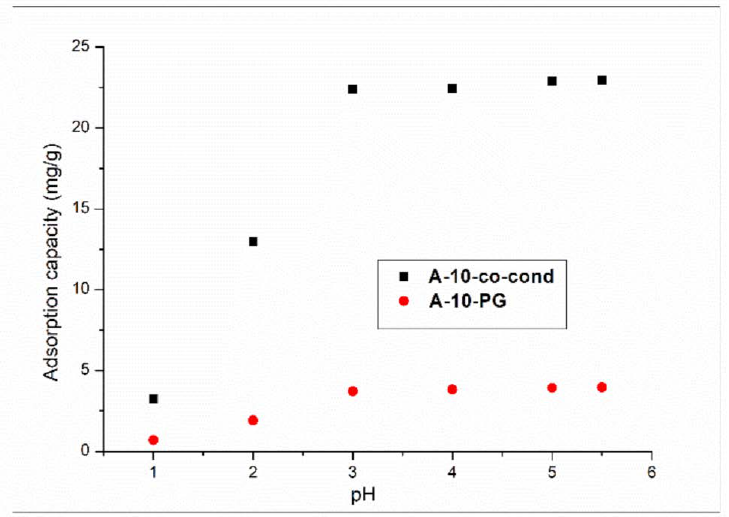
Figure 7. The pH dependence of the adsorption capacity the A-10-co-cond and A-10-PG samples.